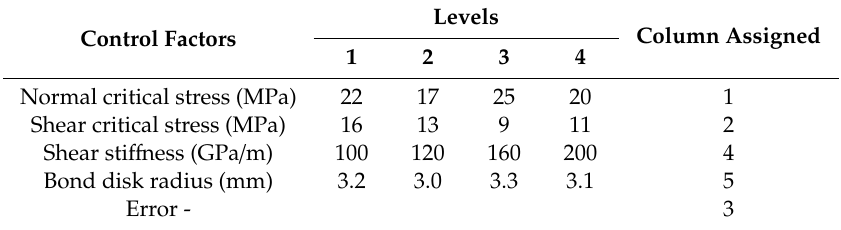
Table 2. The standard L16 array allocated to each parameter.